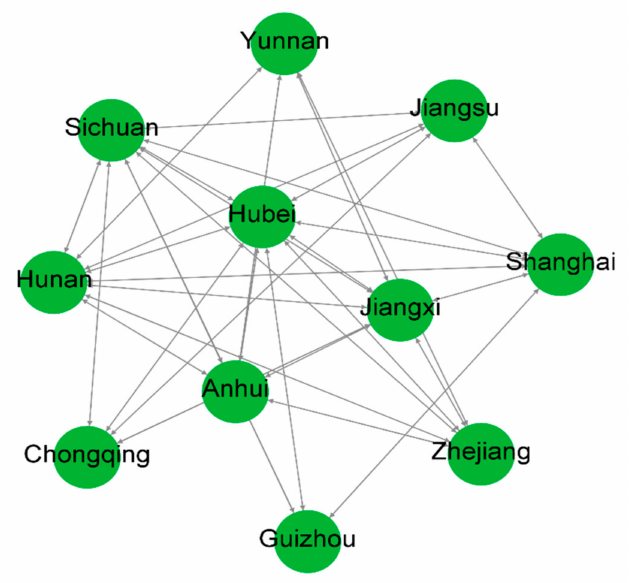
Figure 5. Spatial correlation network of green efficiency of water resources in the Yangtze River Economic